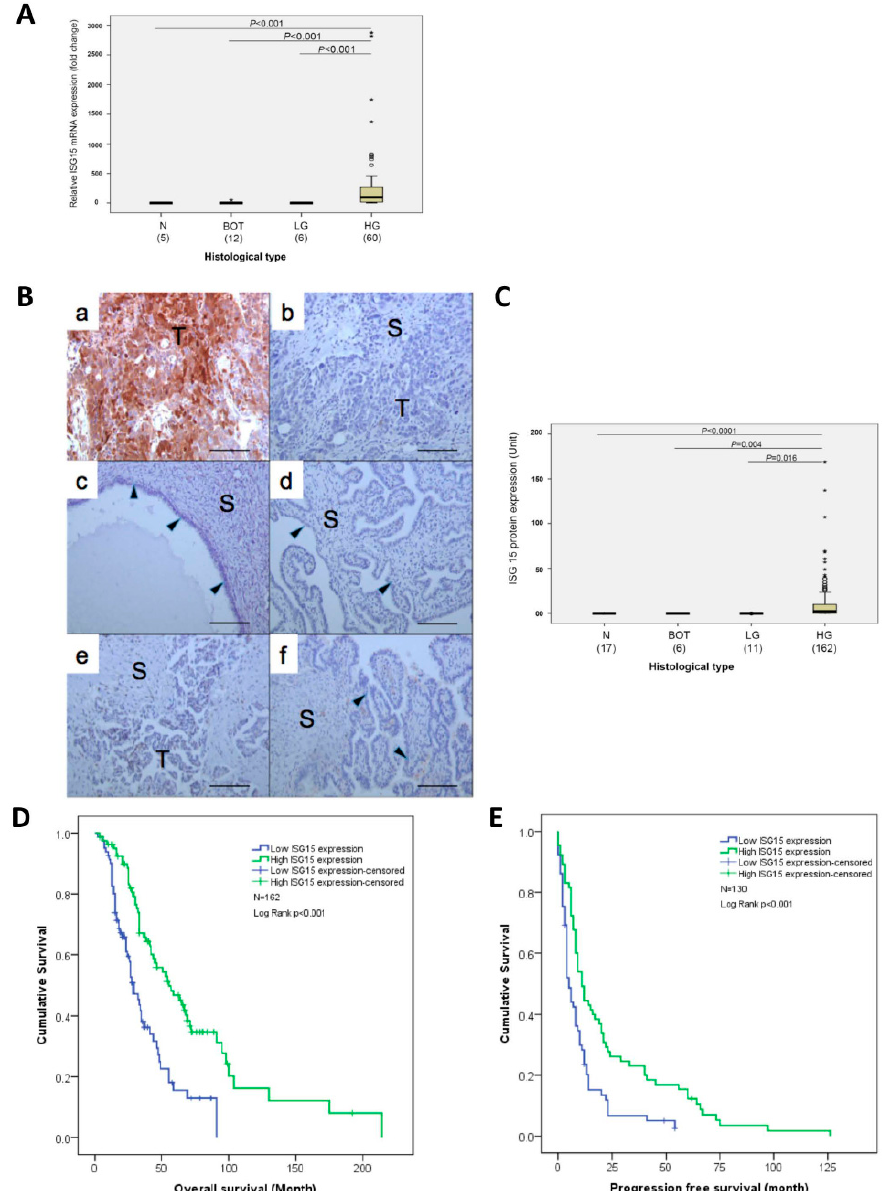
Figure 2. ISG15 protein expression in the tumor epithelium is associated with improved overall and progression-free survival. ( A ) Quantitative reverse transcriptase-polymerase chain reaction (qRT-PCR) analysis on RNA samples isolated from microdissected normal fallopian tube epithelia (N), serous borderline epithelia (BOT), low (LG) and high grade (HG) serous epithelia showed significantly higher levels of ISG15 expression in high grade serous epithelia than in other serous type epithelia. ( B , C ) Immunolocalization of the ISG15 protein in ( a , b ) high grade serous ovarian cancer, ( c ) normal ovarian cyst epithelium, ( d ) normal fallopian tubes, ( e ) low grade serous ovarian cancer and ( f ) borderline ovarian tumors, and showed high levels of ISG15 protein expression only in the epithelial component of the high grade serous ovarian cancer. (Bar = 100 µ m). ( D ) Survival analysis using median ISG15 expression level as a cut off showed that HGSOC patients with high ISG15 expression in the tumor epithelium had a significantly longer median overall survival time (55 months) compared with patients with low expression of ISG15 (29 months) ( p < 0.001). ( E ) Similarly, patients with high ISG15 expression in the tumor epithelium had a significantly longer median progression-free survival time (11 months) than in patients with low ISG15 expression (5 months) ( p <